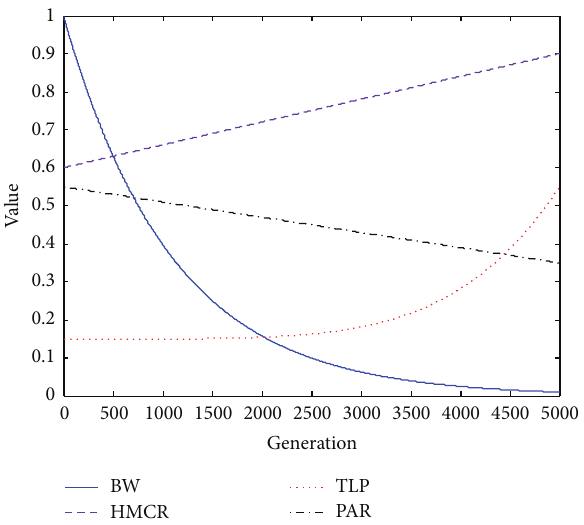
Figure 3: The evolution curves of parameters (HMCR, TLP, PAR, and BW) of HSTL